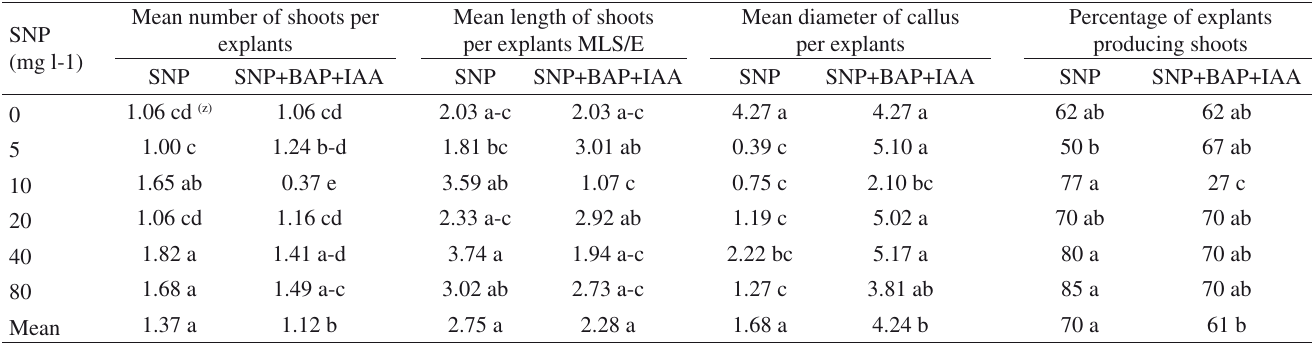
Table 1 - Comparing SNPs and combination of SNPs along with BAP (2.5 mg l -1 ) and IAA (0.1 mg l -1 ) after two weeks on T. undulata (RoxB.) single node